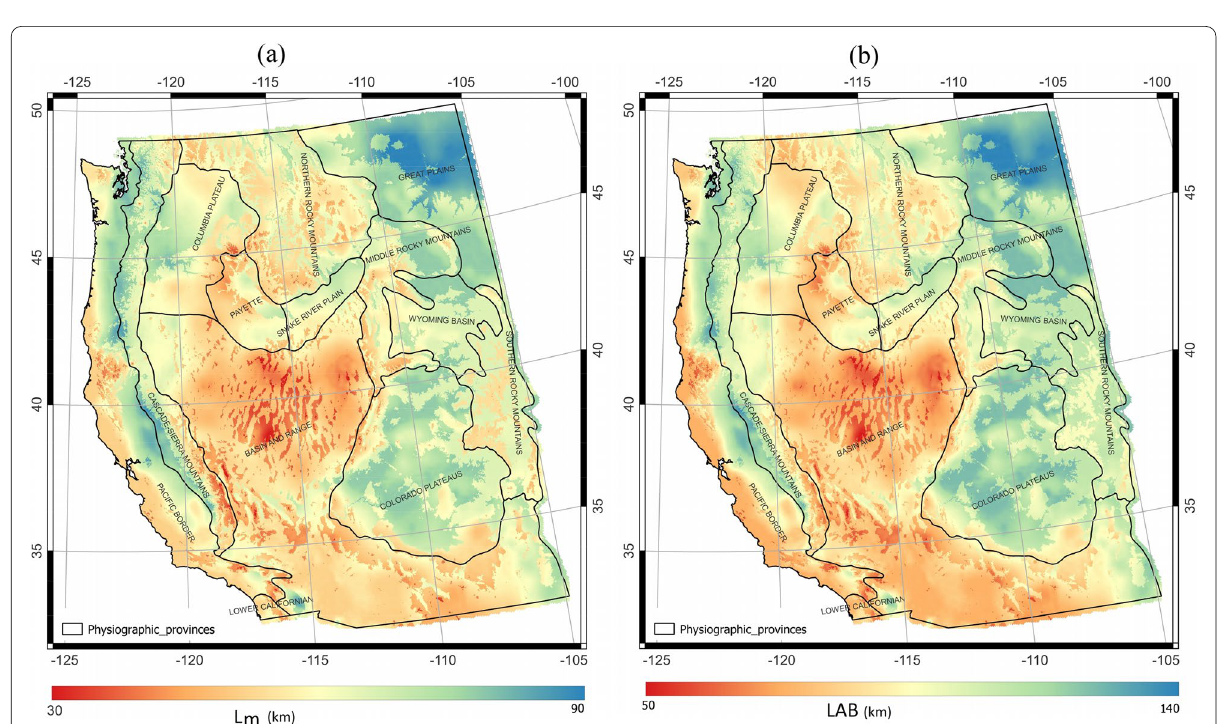
Fig. 11 a Calculated mantle–lithosphere thickness, b calculated depth to the Lithosphere–Athsenosphere Boundary (LAB) in the study